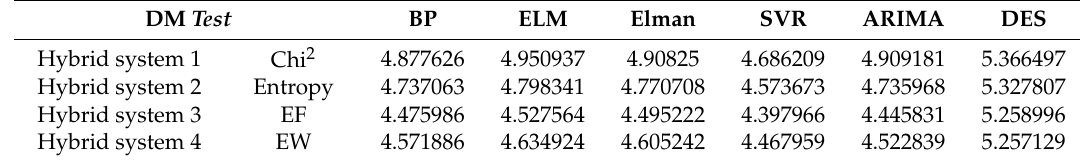
Table 15. DM test results of different models for hourly time horizon wind speed forecasting.